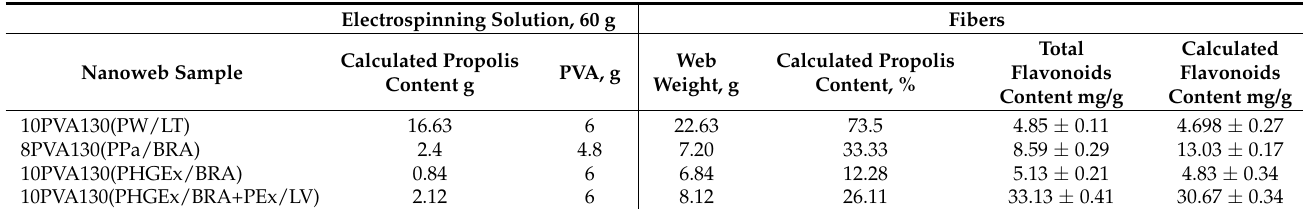
Table 5. Flavonoids and propolis content in